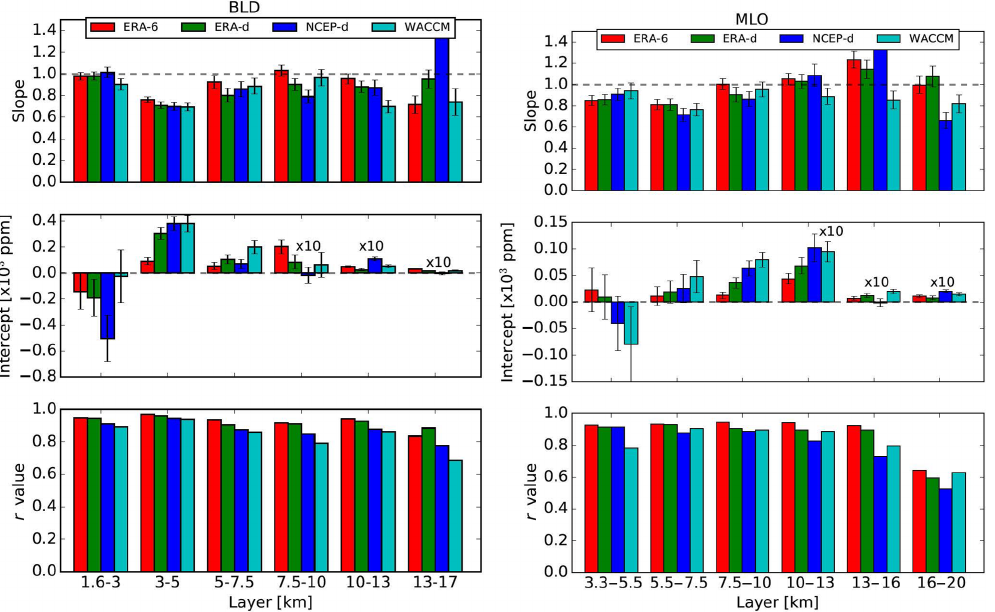
Figure 8. Results of the ODR analysis between the NOAA FPH and FTIR using different a priori profiles at different altitude layers. Error bars represent the standard errors of the estimated parameters. Note that for visibility the intercept obtained in the upper three layers has been multiplied by a factor of 10.